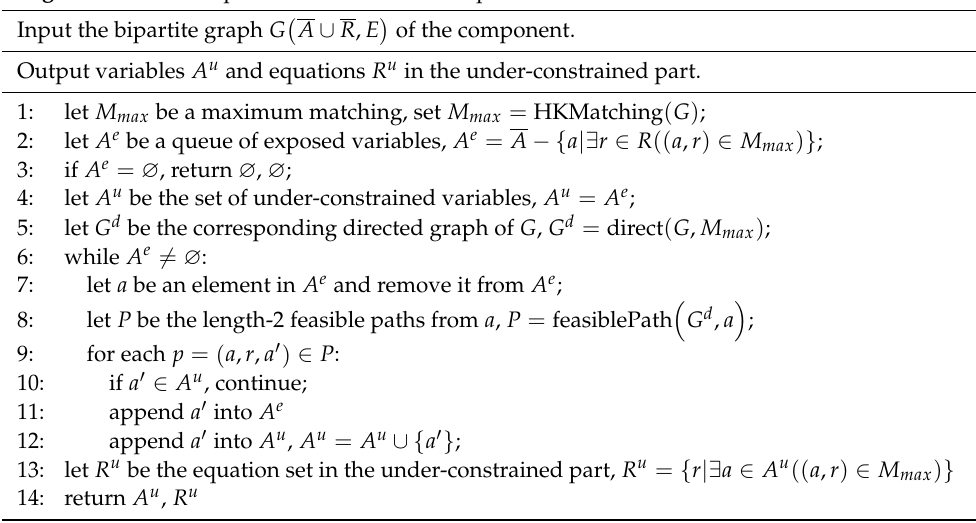
Algorithm 1. Decomposition of an NLAE